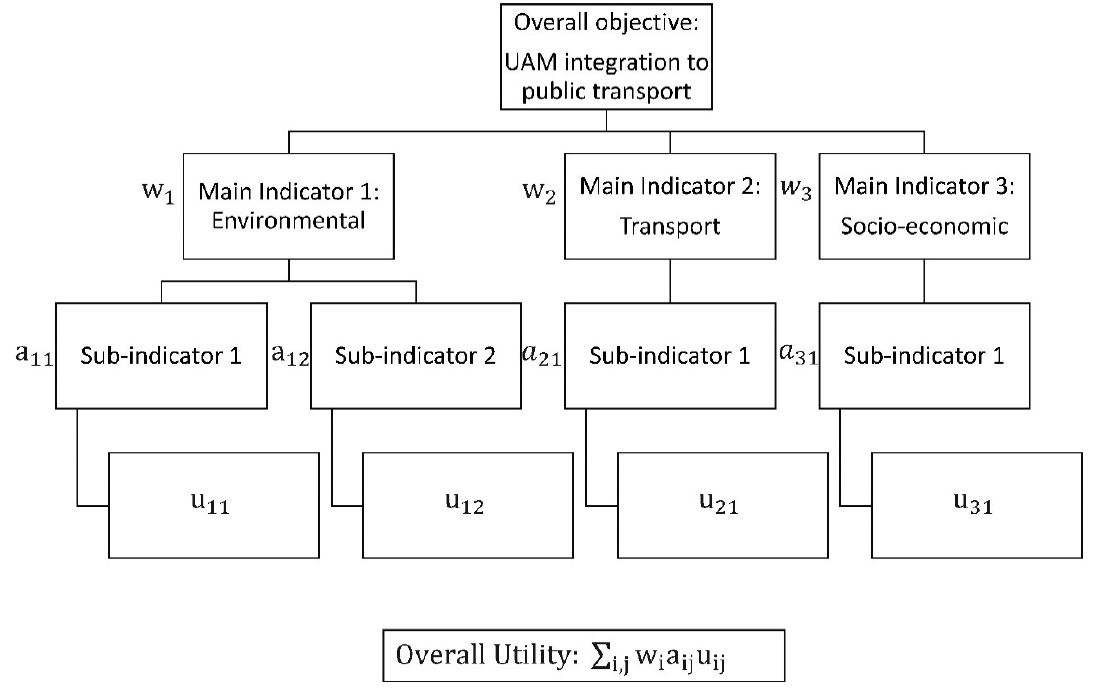
Hierarchical Multi–Criteria